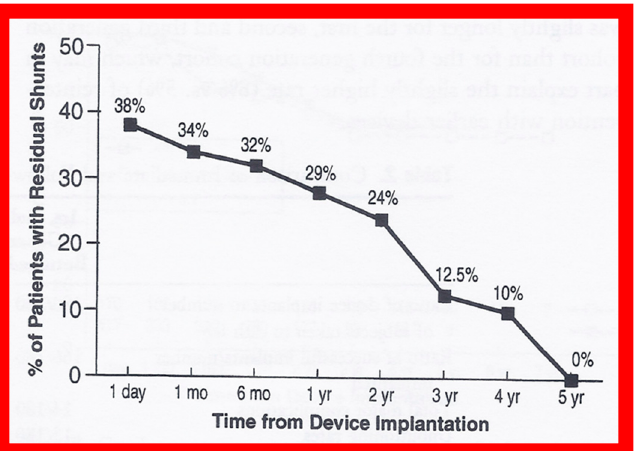
Figure 46. Rates of resolution of residual atrial shunts following occlusion of atrial defects with fourth-generation buttoned devices. The percentage of subjects with residual shunts was calculated as a ratio of the patients with residual shunts divided by the number of subjects examined at that specific follow-up duration. Note the gradual decline in the percentage of patients with residual shunts. mo, month; yr, year. Reproduced from Reference [65].